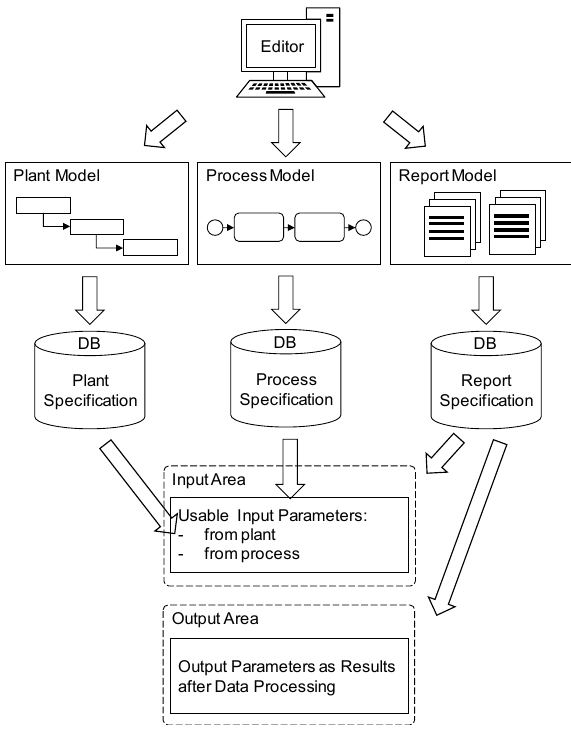
Figure 7. The front-end and its correspondence with the specification.